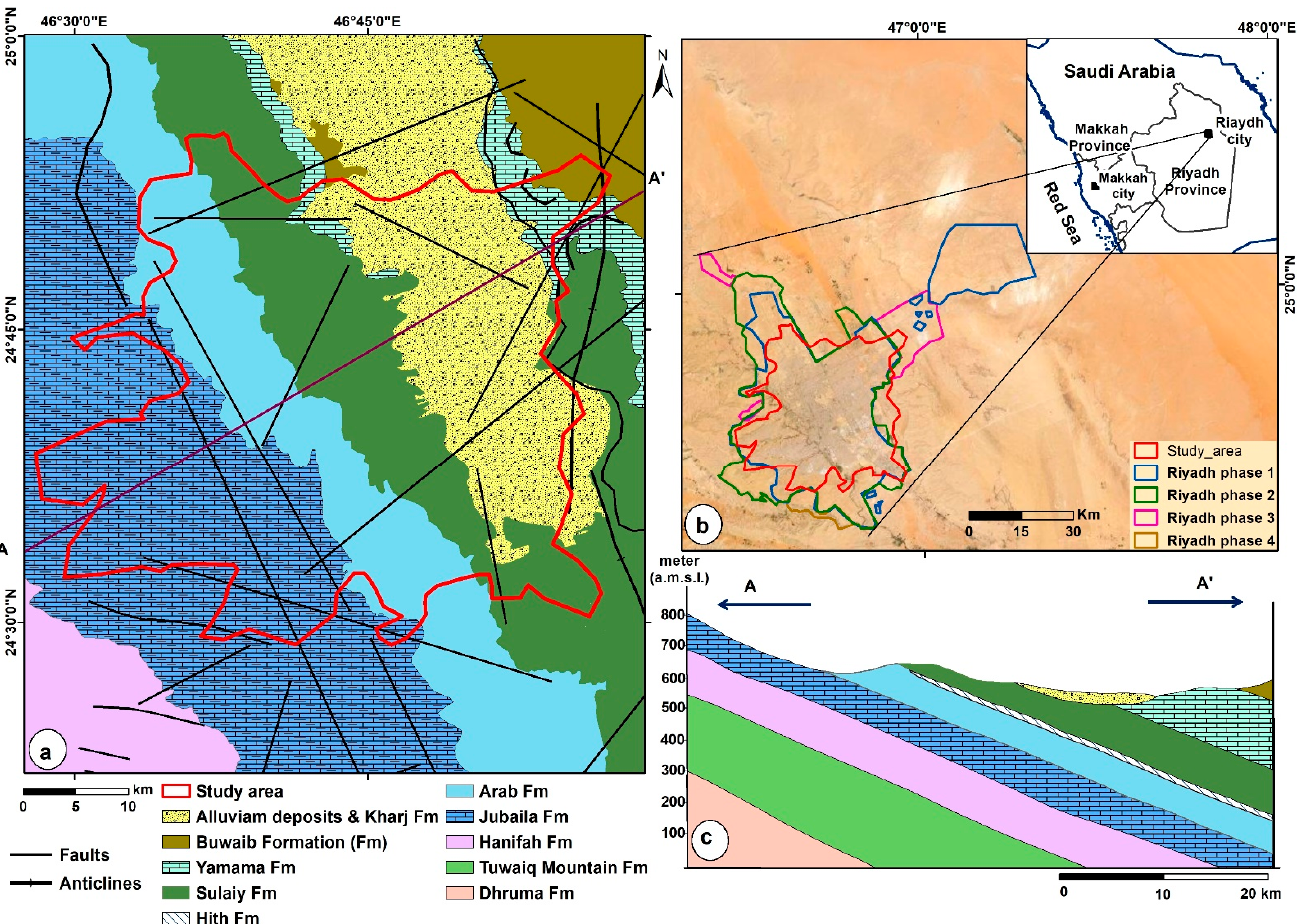
Figure 1. ( a ) Simplified geologic map for Riyadh and its surroundings (modified after [14,15]). ( b ) Location map showing the distribution of the Riyadh Province, the current extension of the city of Riyadh (this work), and the planned extensions (phases 1 through 4) of the city in accordance with the Comprehensive Riyadh Strategic Plan [16]. ( c ) Cross section along line A–A’ in Figure 1a showing the variations in elevations of formations in units of meters above mean sea level (m.a.m.s.l).